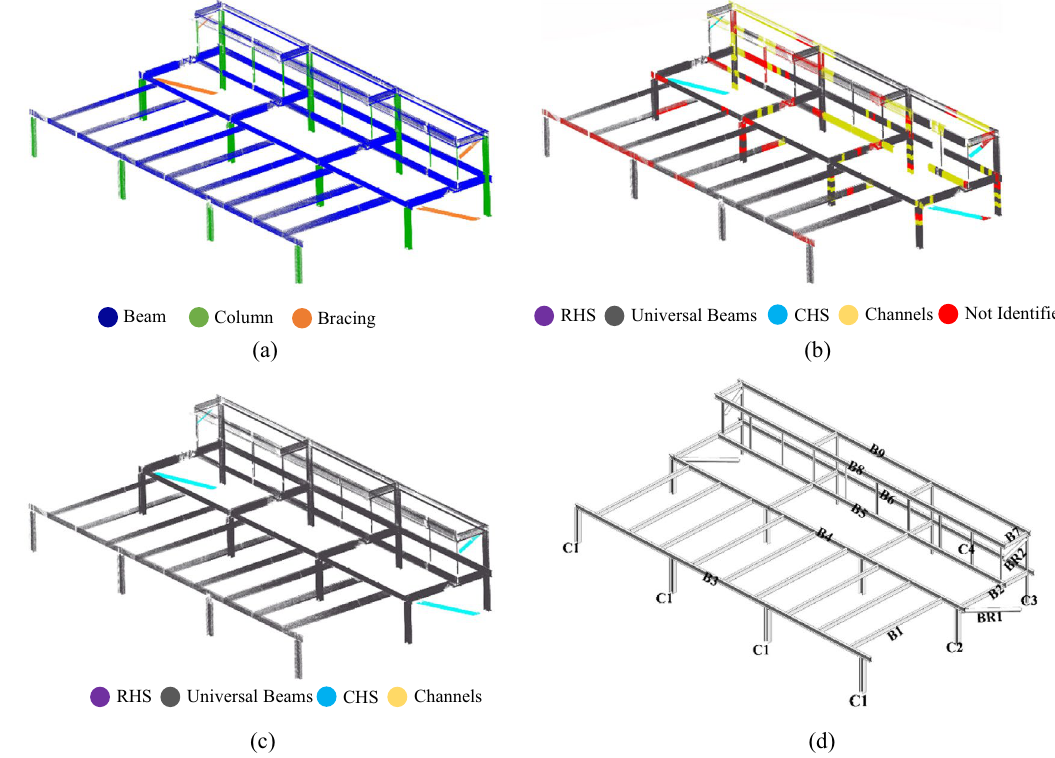
Figure 2. Applying the proposed method to the multi-level carpark case study: ( a ) Obtaining position information for detecting potential structural members. ( b ) Detection of section shapes. ( c ) Homogenization of structural shapes along the length of each member. ( d ) Automatically generated BIM model in